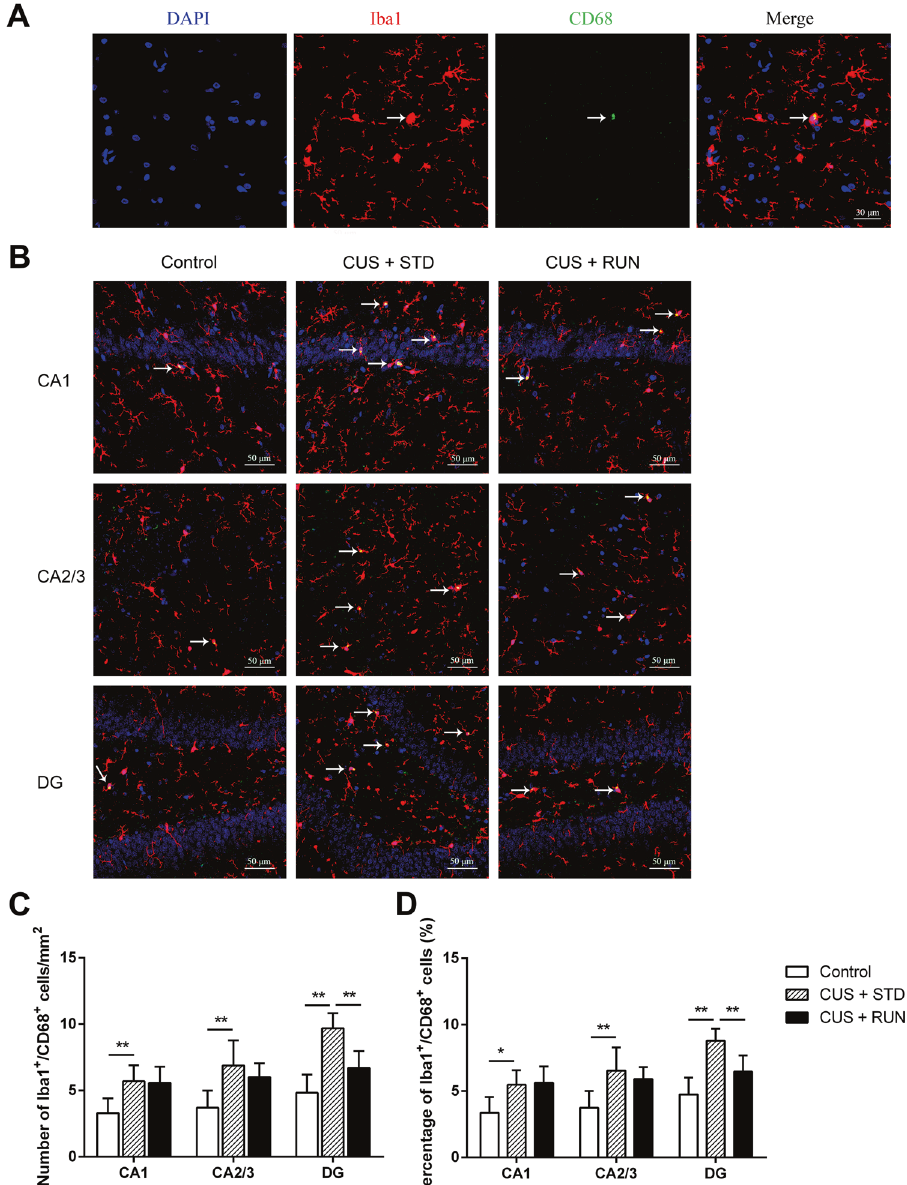
Fig. 4 The effects of running exercise on the density and ratio of activated microglia in sub fi elds of the hippocampus in CUS-exposed rats. A Representative confocal images of Iba1 + /CD68 + microglia in the hippocampus. Scale bar = 30 μ m. B Representative confocal images of immuno fl uorescence staining using antibodies against Iba1 and CD68 in the hippocampal subregions in the control group, the CUS + STD group, and the CUS + RUN group. The arrowheads indicate representative Iba1 + /CD68 + cells. Scale bar = 50 μ m. C , D Quantitative analyses comparing the densities and percentages of Iba1 + /CD68 + cells in the CA1, CA2/3, and DG areas among the control group, the CUS + STD group, and the CUS + RUN group. The data are expressed as mean ± SD (n = 5 per group). * p < 0.05 and ** p < 0.01. CUS + STD CUS + standard, CUS + RUN CUS +